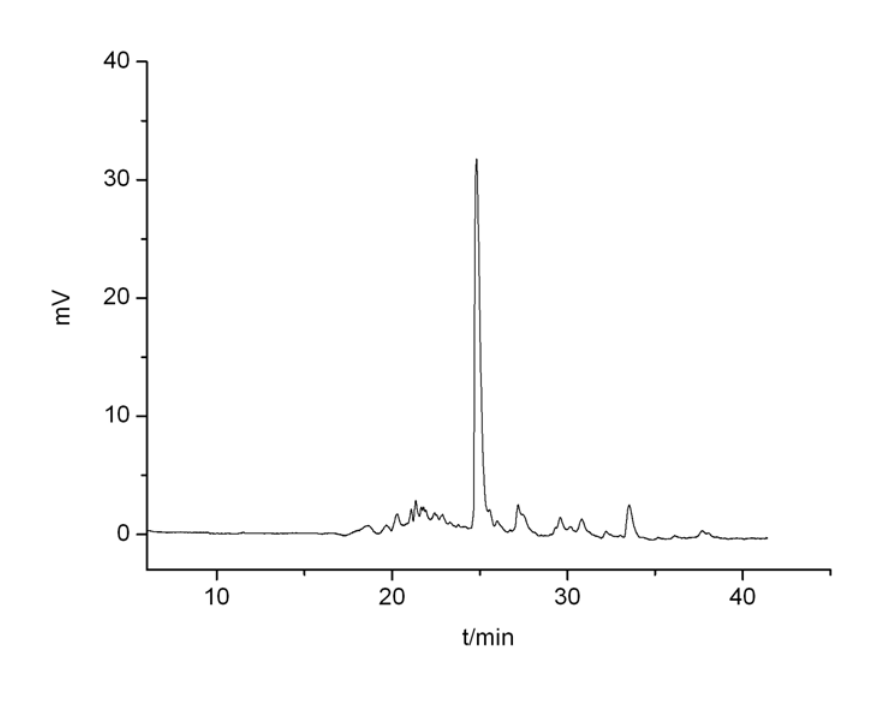
Fig. 2 RP-HPLC profile of crude heptapeptide 1 (t R 24.80 min).